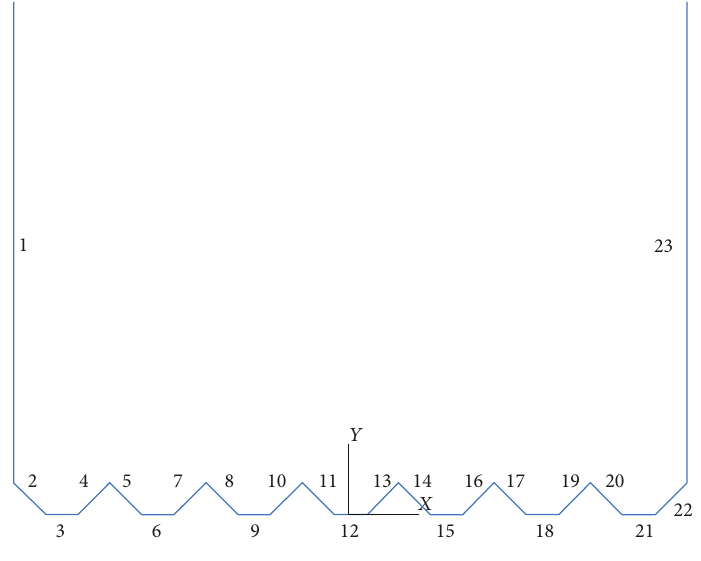
Figure 2: Wall structures of the